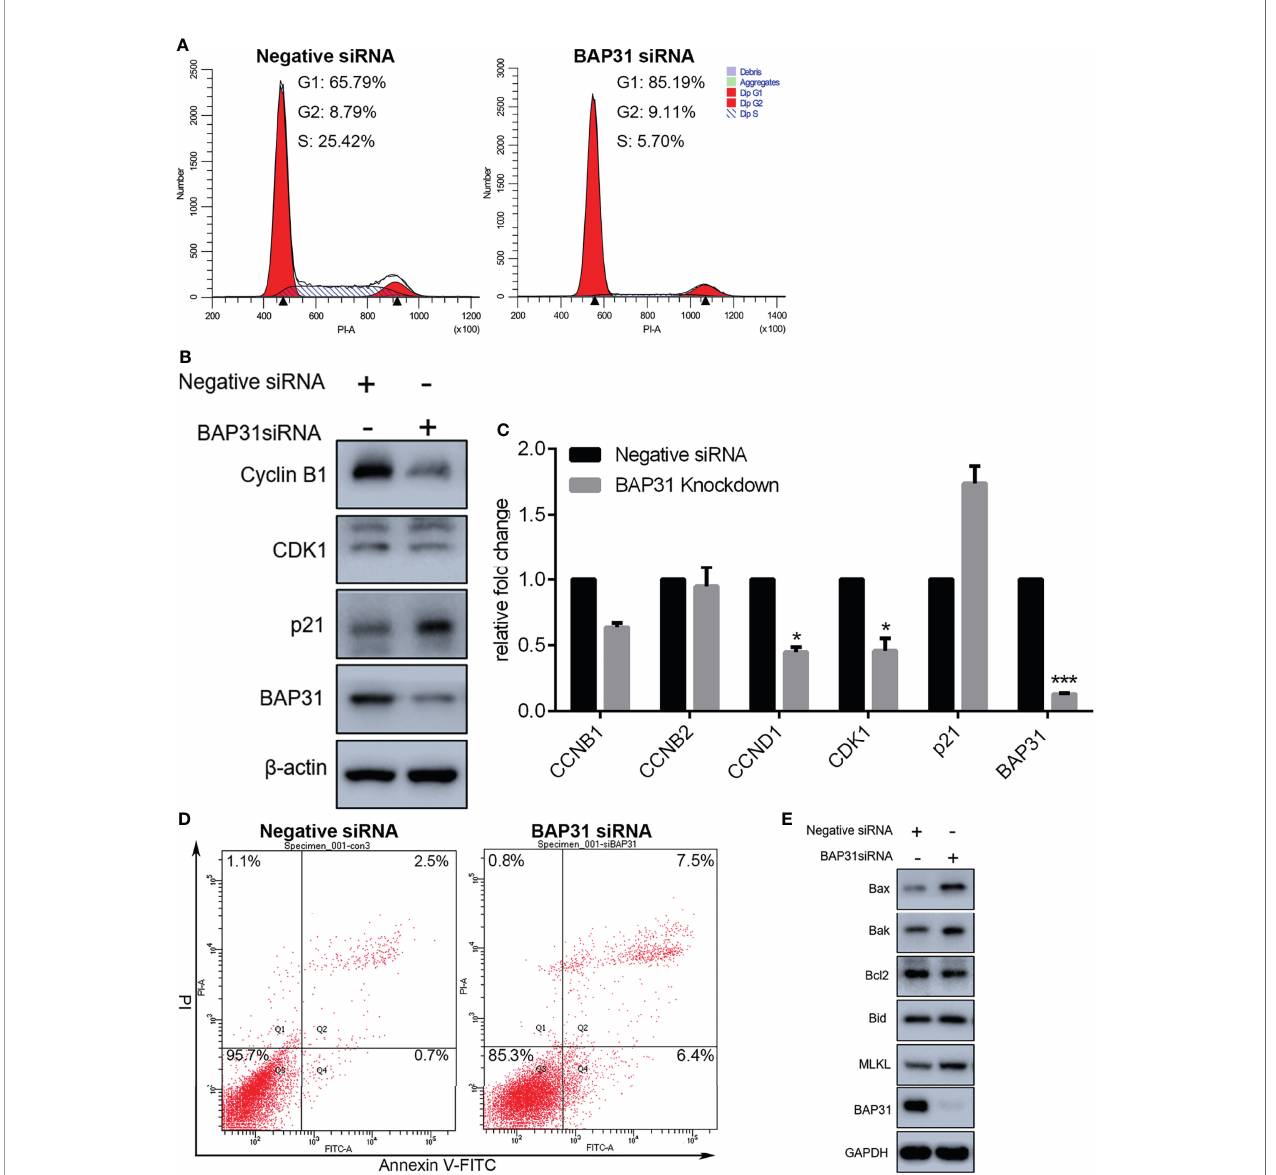
FIGURE 2 | Cell cycle distribution and apoptosis induction analysis in A549 lung cancer cells with BAP31 siRNA knockdown. (A) Cell cycle distribution was determined by PI staining using fl ow cytometry. (B) Expression of cell cycle associated genes as evaluated by Western blot analysis. (C) Expression of cell cycle associated genes as examined by qPCR (mean ± SEM of duplicate experiments). * p < 0.05 versus control, and *** p < 0.001 versus control. (D) Apoptosis in lung cancer cells was determined by annexin V-FITC/PI staining using fl ow cytometry. (E) Expression of apoptosis genes as evaluated by Western blot